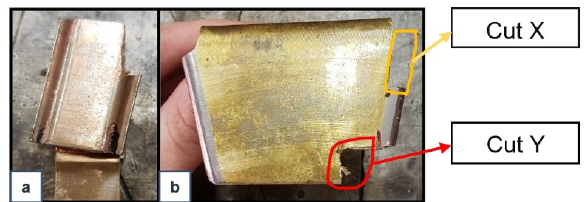
Figure 6. Mobile contact ( a ) and fixed contact ( b ) after sample removal from each contact to perform the tests.